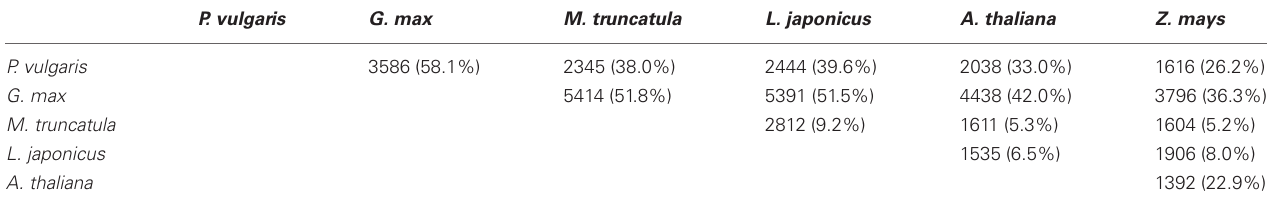
Table 6 | Number of sORFs from legume species predicted to be orthologous to each other.